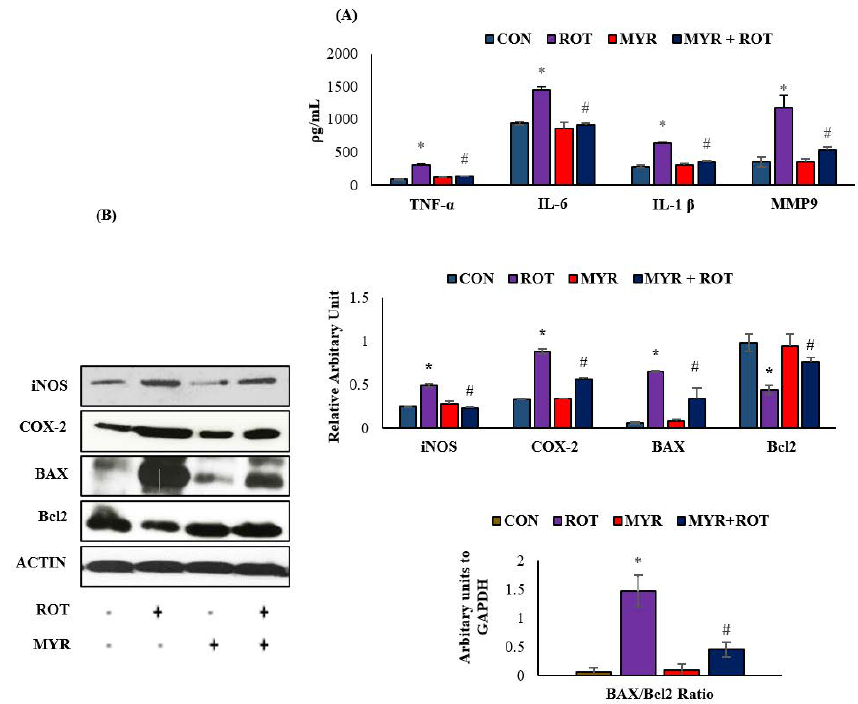
Figure 2. ( A ) . The effect of myrcene on the levels of pro-inflammatory cytokines; TNF- α , IL-6, IL-1 β , and MMP-9. The values are expressed as mean ± SEM ( n = 6–8). * p < 0.05 (ROT vs. CON), # p < 0.05 (MYR vs. ROT). ( B ). The effect of myrcene on the expression of inflammatory enzymes (iNOS and Molecules 2023 , 28 , x FOR PEER REVIEW COX-2) and apoptotic markers (BAX, Bcl-2 and BAX/Bcl-2 ratio). The values are expressed as percent mean ± SEM ( n = 3). * p < 0.05 (ROT vs. CON), # p < 0.05 (MYR vs. ROT).